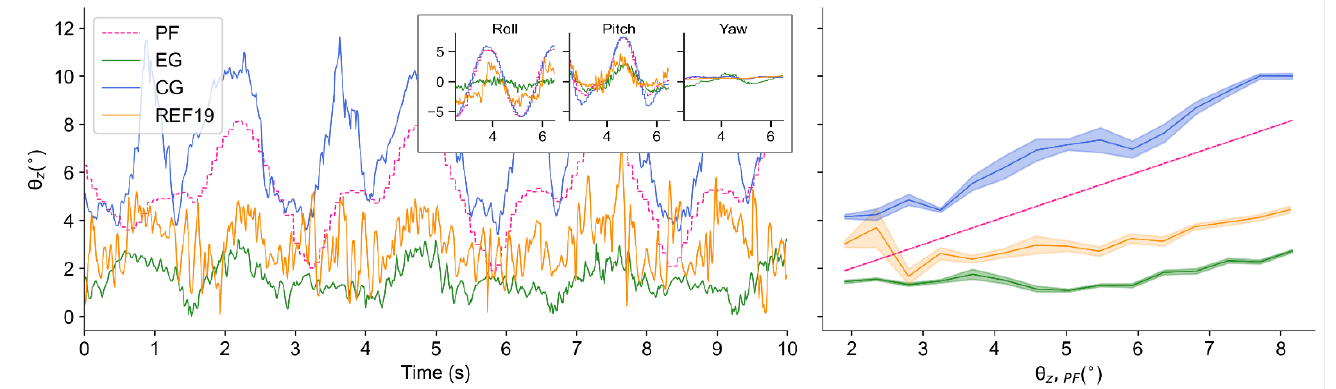
Figure 6. Tilt angles θ z of PF, CG, EG and REF19 when δ = 100 ◦ /s and ε = 90 ◦ : Time-domain variations of tilt angles ( left ); Balance performance at varying tilt angles of PF ( right ).